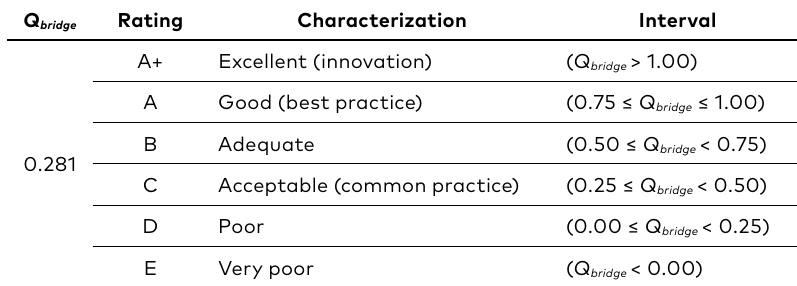
Table 5. Q bridge and proposed quality bridge performance-rating scale Q